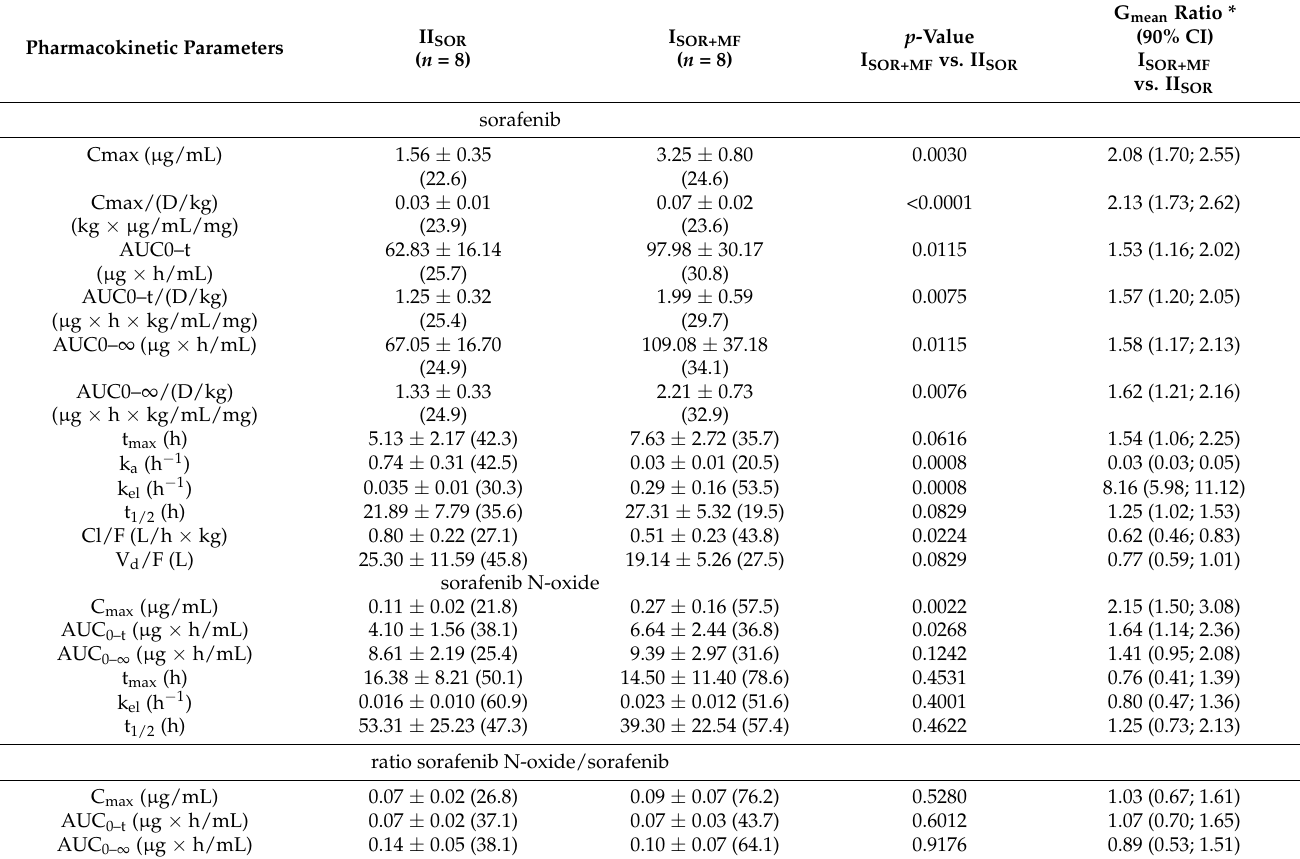
Table 1. Pharmacokinetic parameters of sorafenib and its metabolite sorafenib N-oxide after a single oral dose of100 mg/kg b.w. of sorafenib (II SOR group) and a single oral dose of 100 mg/kg b.w. of sorafenib + single intraperitoneal dose 5 mg/kg b.w. of morphine (I SOR+MF